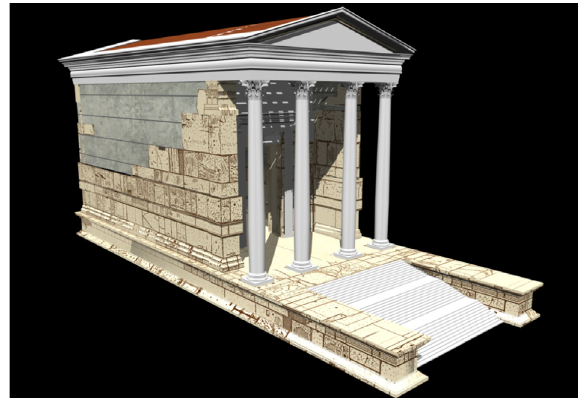
Figure 9. Architectural 3D model of the temple A of Hosn-Niha . © J. Yasmine; 2005.